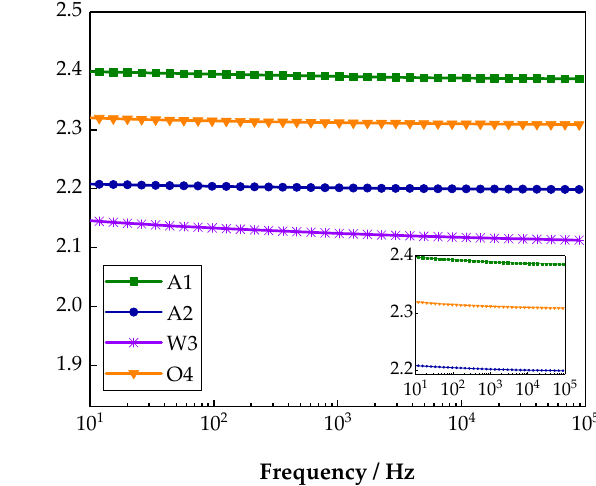
Figure 5. Frequency dependences of the relative permittivity of various samples.